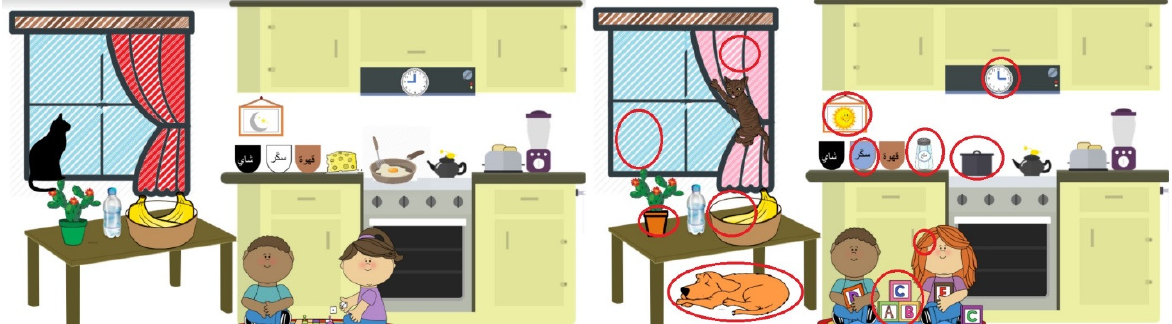
Figure 2. Example of a completed picture scene (kitchen scene); on the right is the picture with twelve differences